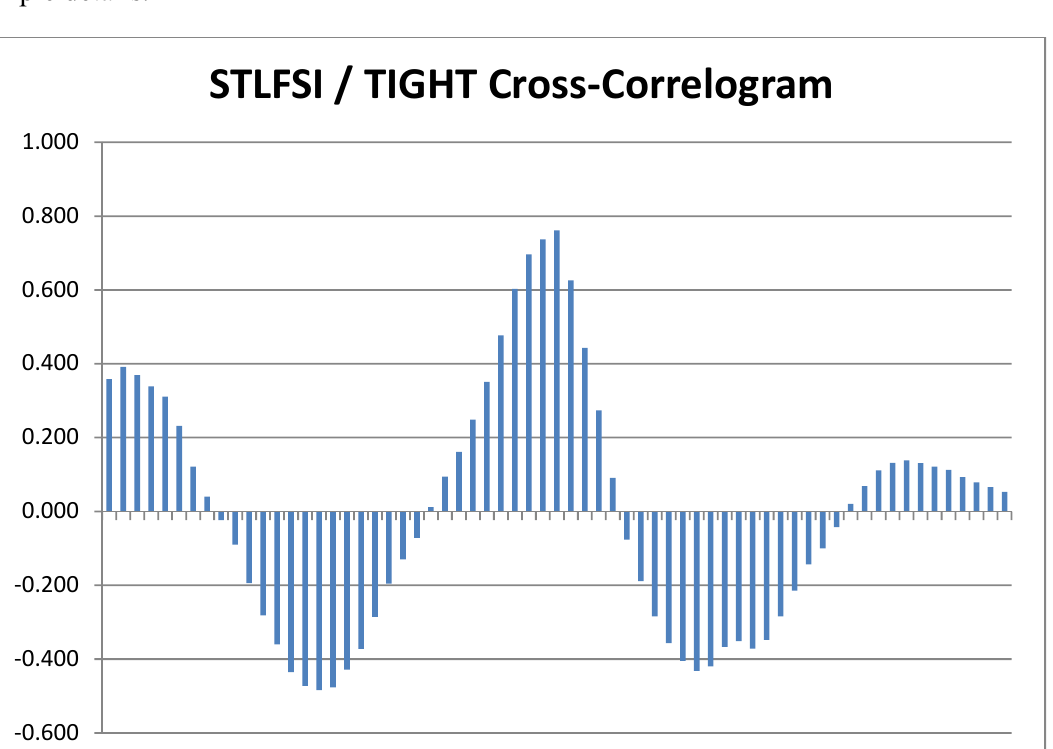
Figure 4 Cross-Correlogram with lags and leads on the x-axis. See Figure 1 caption for sample